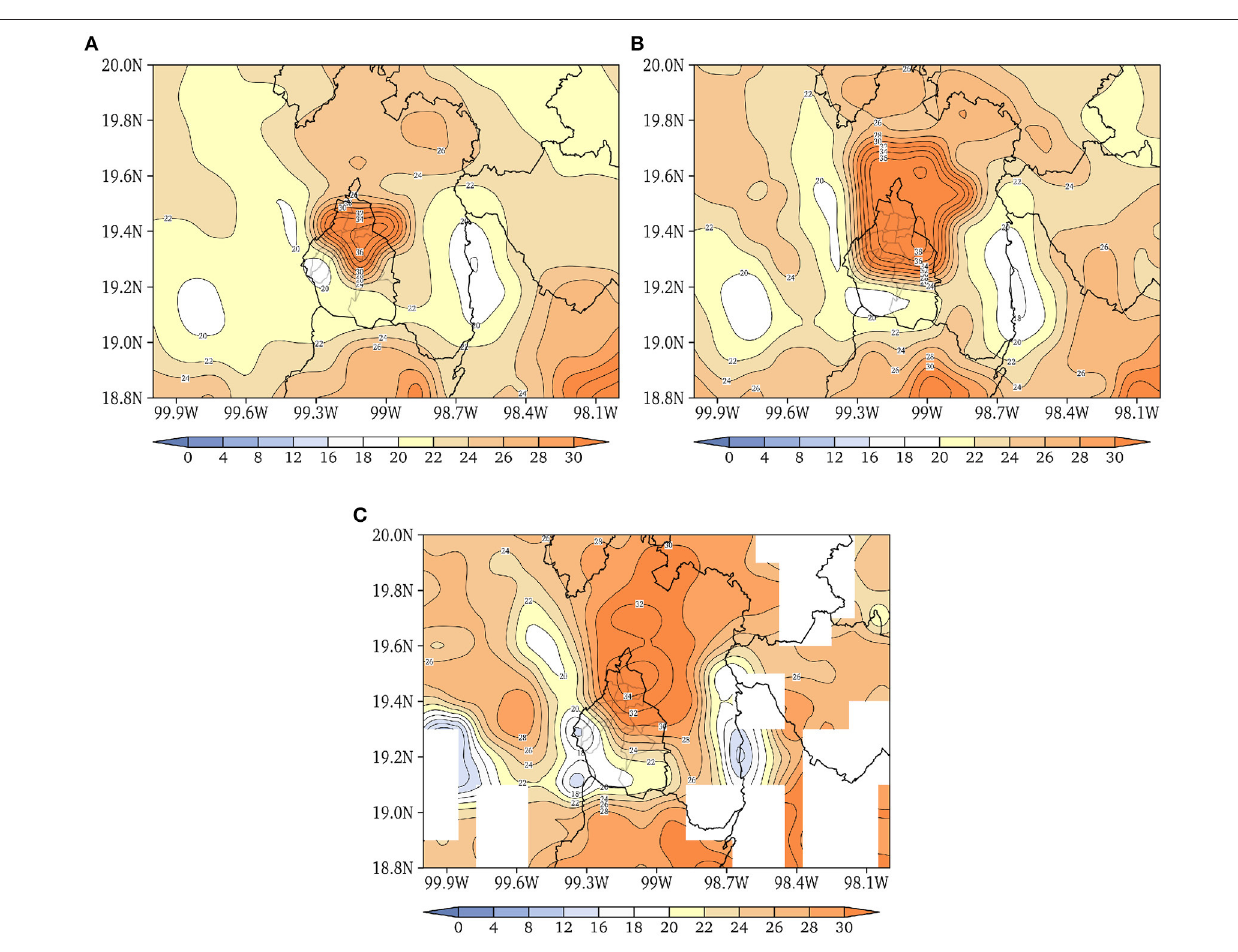
Frontiers in Earth Science | www.frontiersin.org